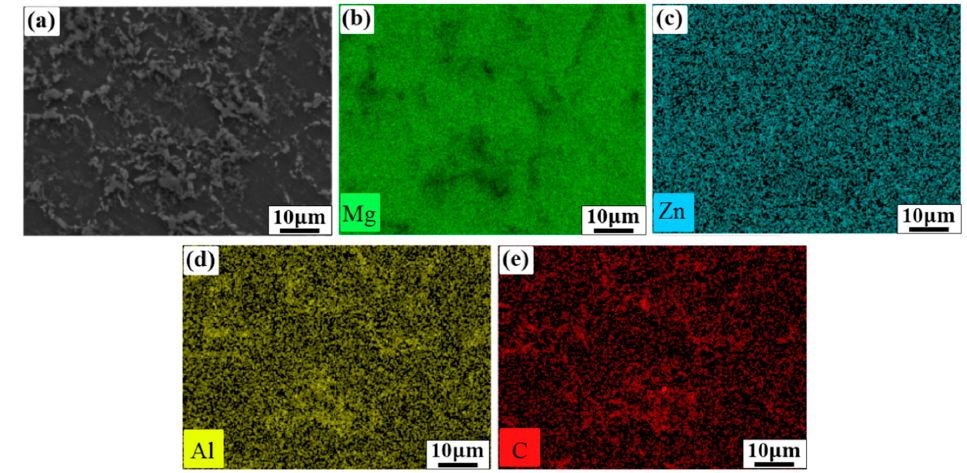
Figure 5. ( a ) SEM images of the 2.0GNPs / AZ31 composites, and ( b – e ) EDS mapping of Mg, Zn, Al and C, respectively.